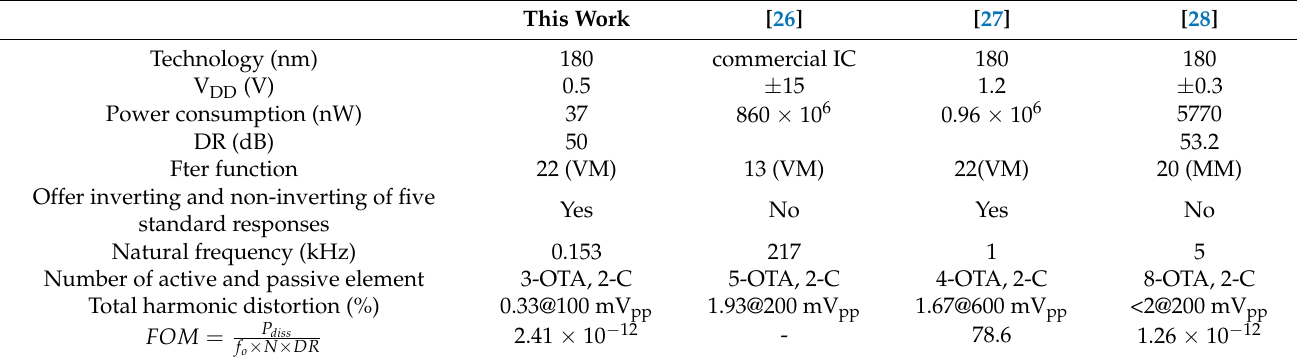
Table 3. Comparison with other